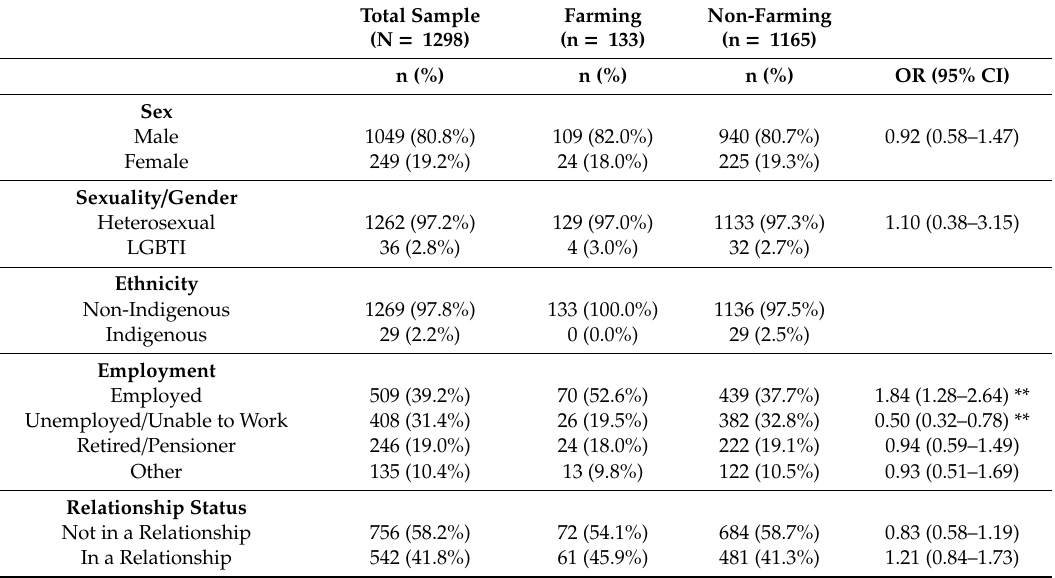
Table 1. Demographics of Suicide Deaths, Farming- and